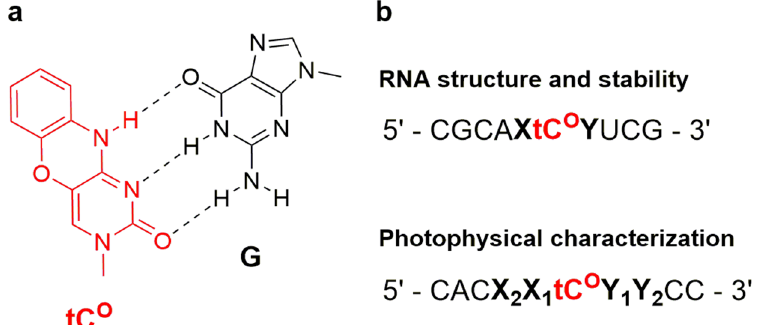
Figure 1. ( a ) The structure of tC O (red) base-paired with guanine (G). ( b ) RNA sequences investigated in this study. Sites of variation in the 5 ′ - and 3 ′ -direction of tC O are denoted with X and Y, respectively. XY and X 2 X 1 Y 1 Y 2 are given as sequence names in Tables 1 and 2, respectively, and the full sequences can be found in Supplementary Table S1.